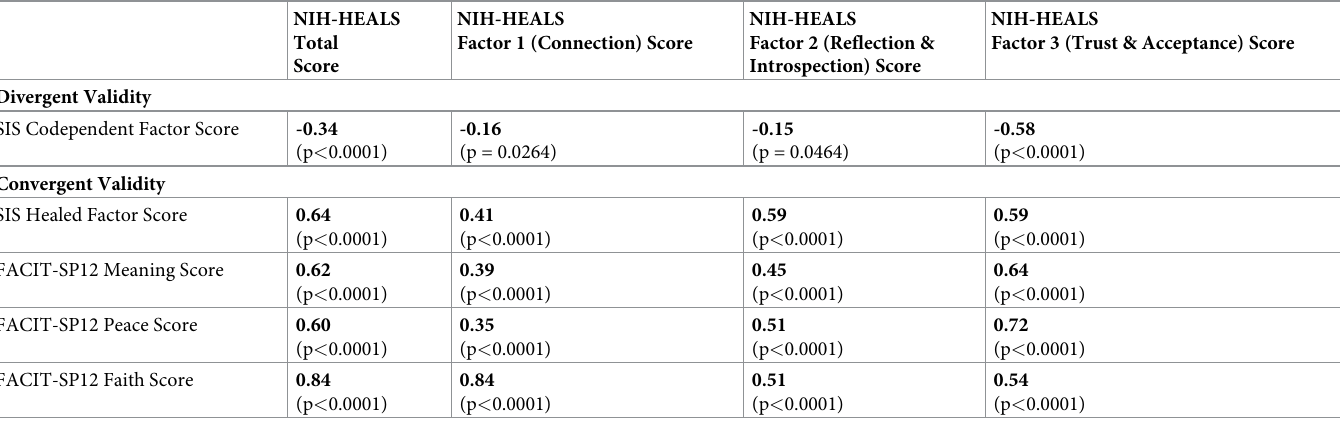
Data are Spearman’s correlation coefficients and corresponding p-values.